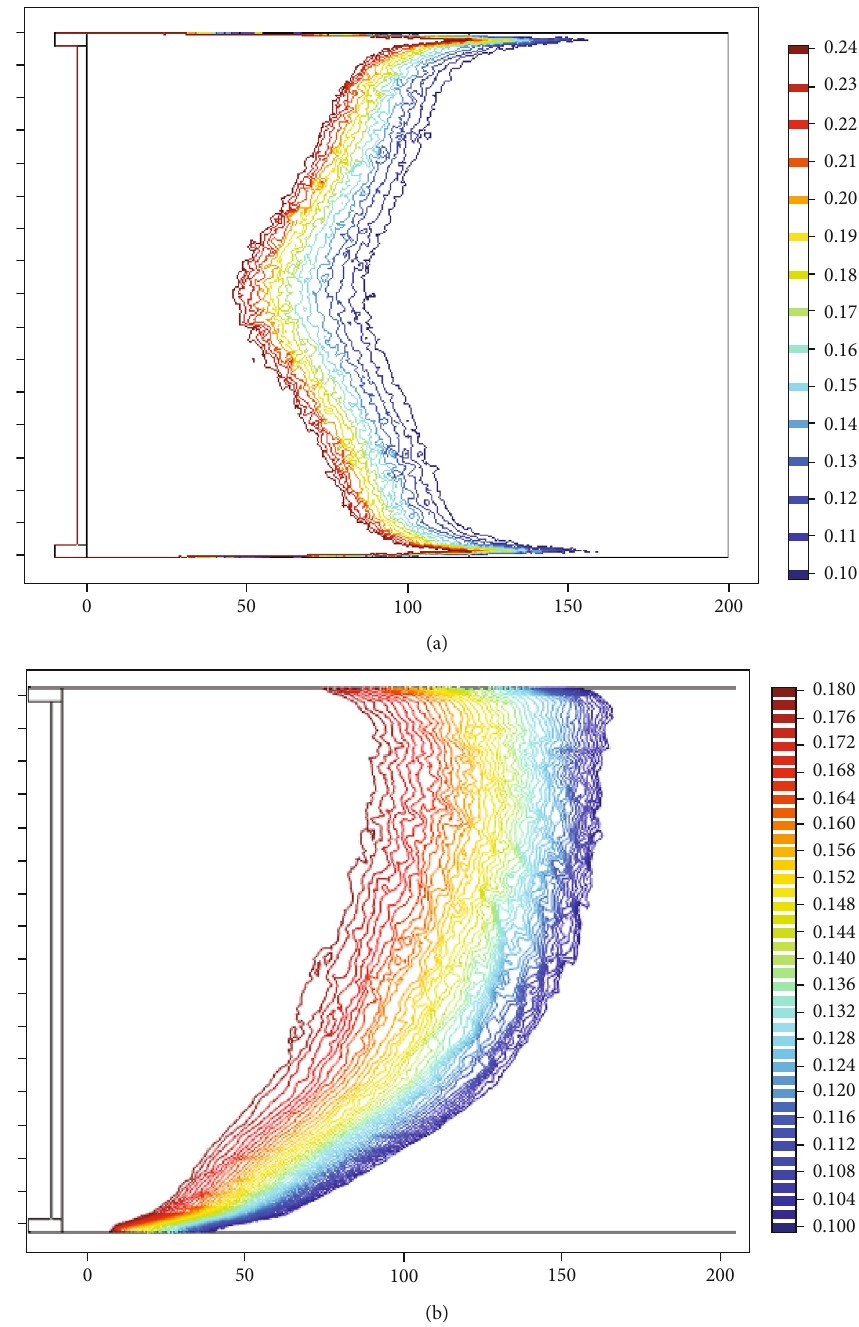
Figure 8: Distribution of oxidation zone at z = 1 : 5m of goaf fl